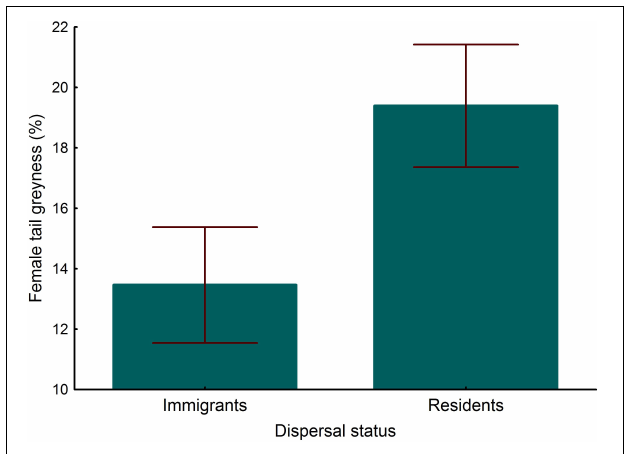
FIGURE 4 | Differences in tail grayness between immigrant and resident breeding females. Bars and whiskers represent mean and s.e. values, respectively.